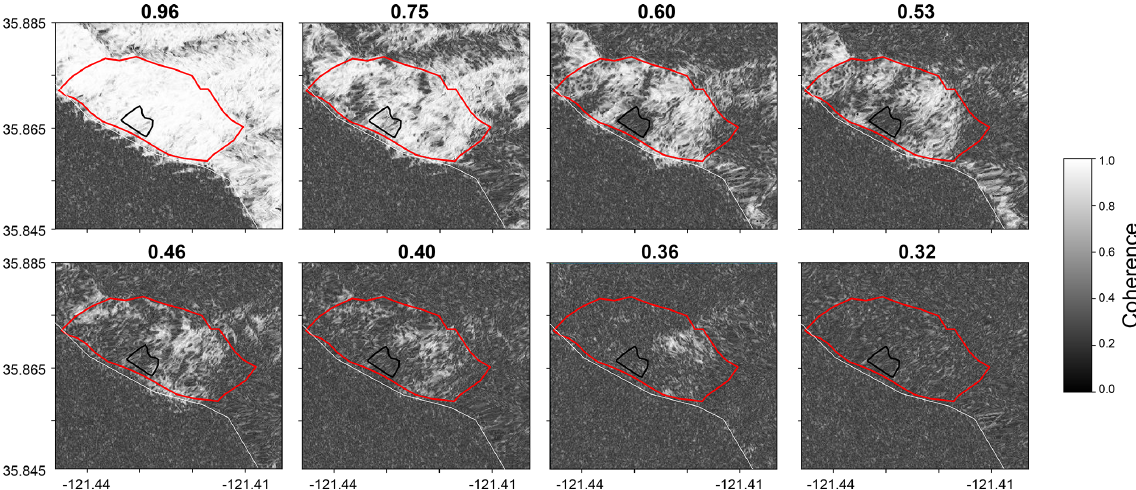
Figure 2. Coherence filtering: interferograms in the upper row exceed the coherence threshold of 0.5 and were therefore included in the ratio analysis; the images in the lower row were excluded. We calculated the mean coherence for the area in the red polygon. The images represent various times during the study period and were chosen purely to show why low-mean-coherence images cannot be used for the ratio calculation. The 20 May 2017 landslide occurred inside the black outline (corresponding to dashed gray line in Fig. 8). Coherence derived from Copernicus Sentinel-1